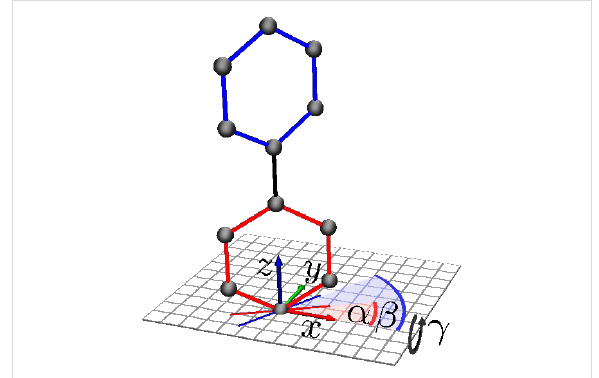
Figure 2: Sketch of the parameters describing a single BPT precursor molecule: α and β denote the rotational angles about the z -axis of the lower and upper phenyl relative to the x – y surface coordinate system (anticlockwise from x -axis); their difference gives the twist angle. The tilt angle γ parameterizes the canting of the molecular axis with respect to the surface given by an anticlockwise rotation about the x -axis.